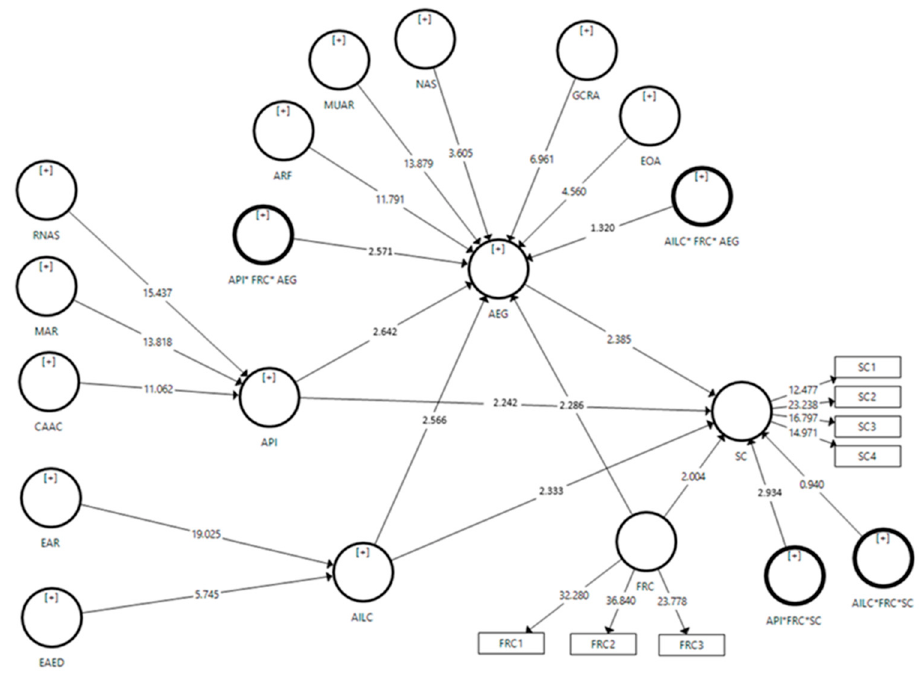
Figure 2. Structural model.